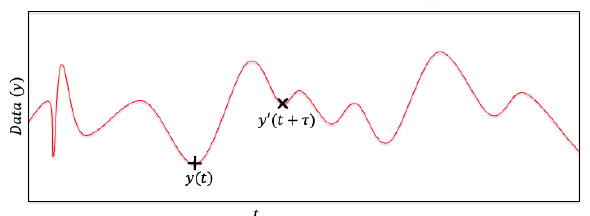
Figure 4. Methodology to obtain conditional probability from the time-series